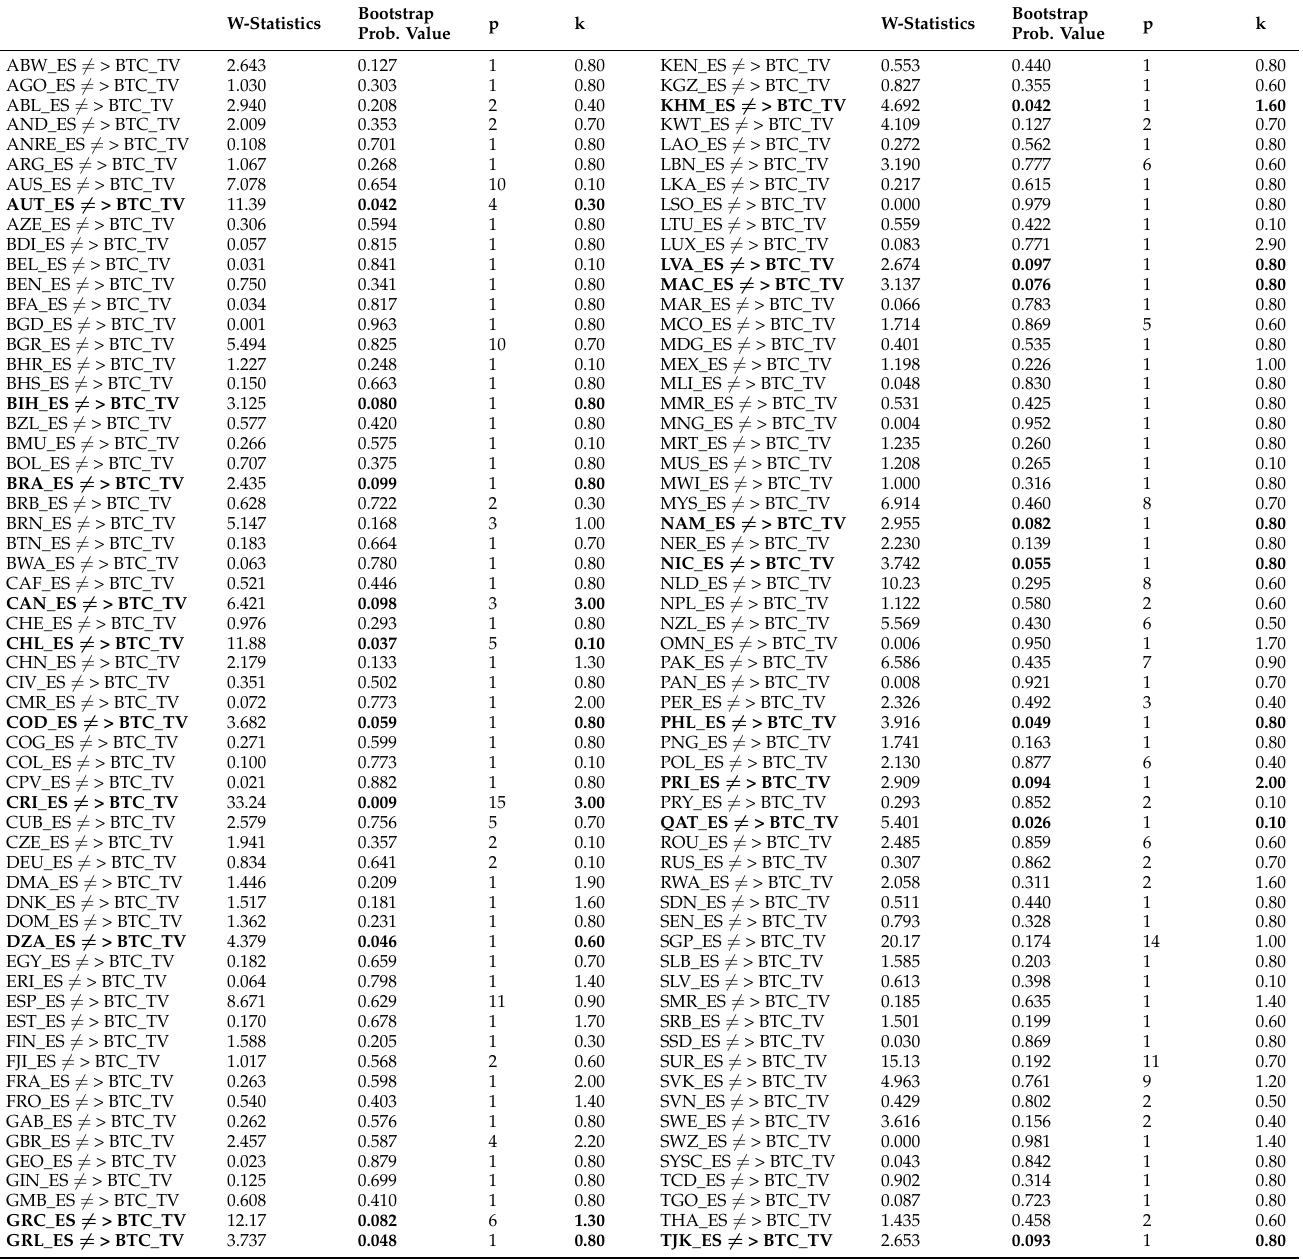
Table 6. Fractional Frequency Flexible Fourier form Toda–Yamamoto causality tests between eco- nomic supports and the trading volume of Bitcoin